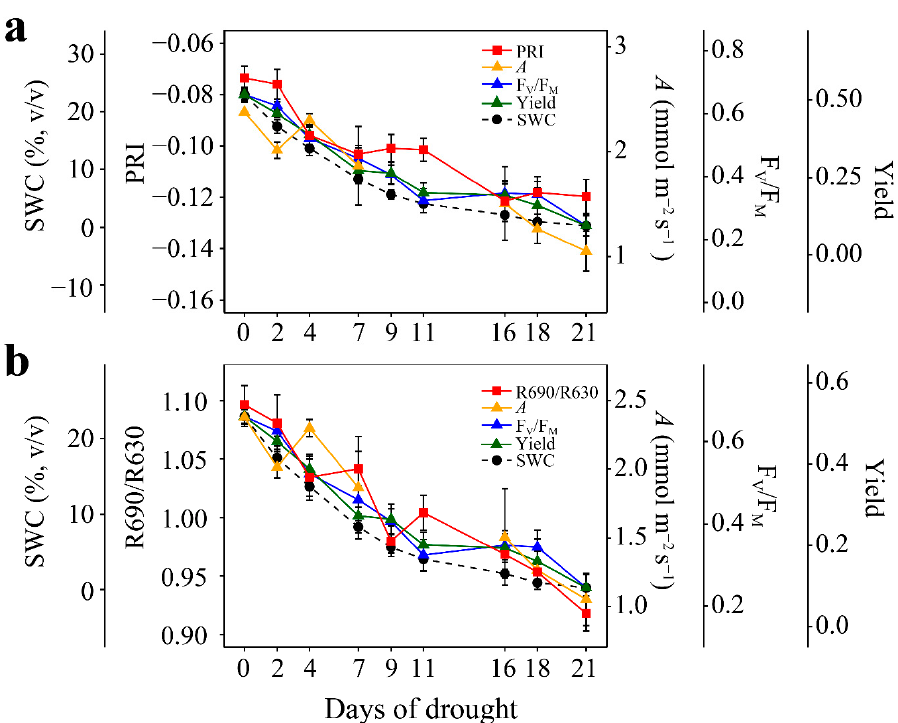
Figure 1. Changes in CO 2 assimilation rates ( A ), maximum (F V /F M ) and actual (Yield) photochemical efficiency of photosystem II ( Φ PSII), and soil water content (SWC) with the photochemical reflectance index (PRI) ( a ) and with reflectance ratio R690/R630 based on the red-edge region of the spectrum ( b ) in response to nine different drought levels treatment for Quercus ilex . Error bars denote the standard errors of the mean ( n = 9).